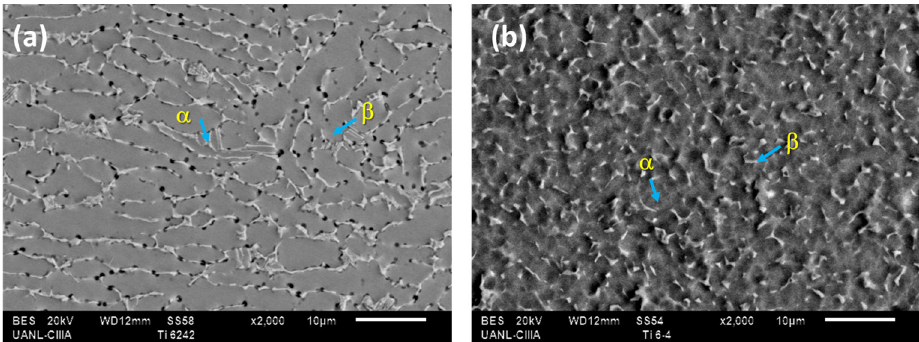
Figure 1. Micrograph obtained by SEM-BES: ( a ) Ti-6Al-2Sn-4Zr-2Mo and ( b ) Ti-6Al-4V.